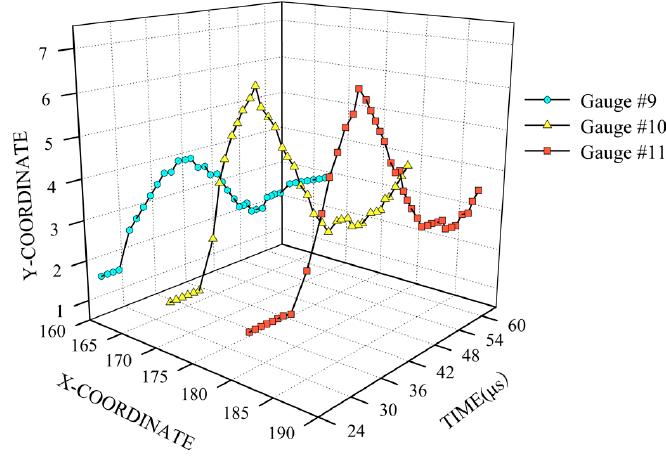
Figure 12. Trajectory of gauge points 9, 10 and 11.